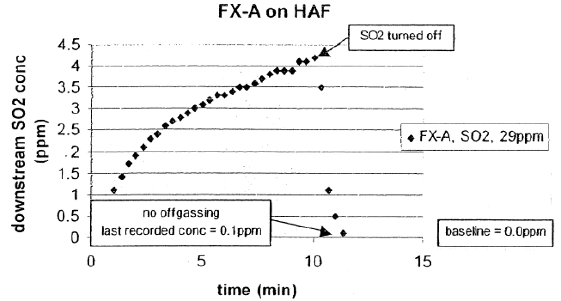
Figure 3. Evidence of minimal off-gassing of SO sample (Sample A).